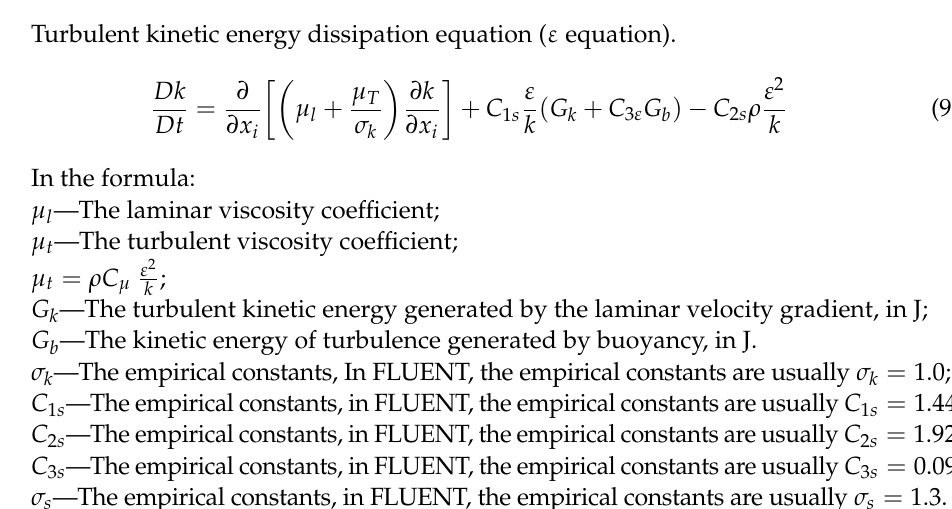
Figure 4. 3D model of the elbow. Figure 5. The mashing result. 2.3.2. Boundary Condition Setting